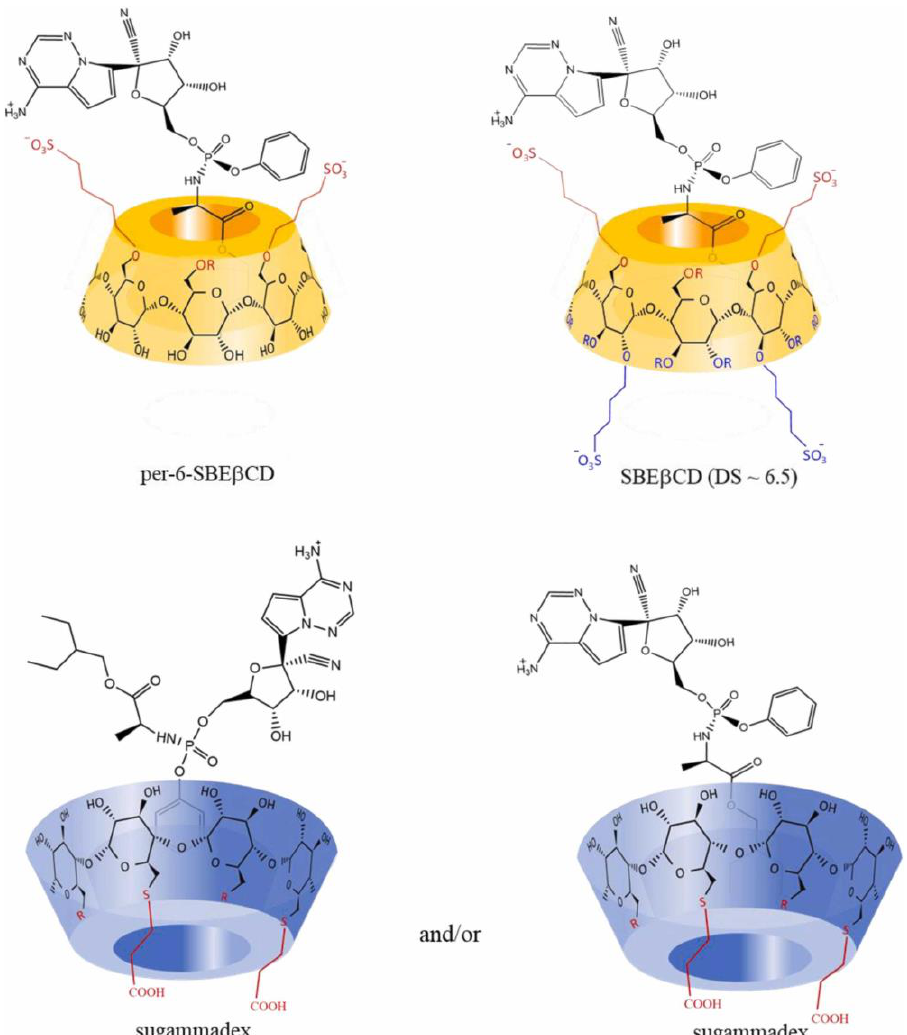
Figure 6. Suggested structures of inclusion complexes of the two β -cyclodextrins (CDs) derivatives (yellow) and remdesivir (REM) and the proposed sugammadex-REM complexes (blue) based on 2D ROESY NMR spectra (under pH 2.0 conditions). Reprinted from [46], Copyright (2022), with permission from